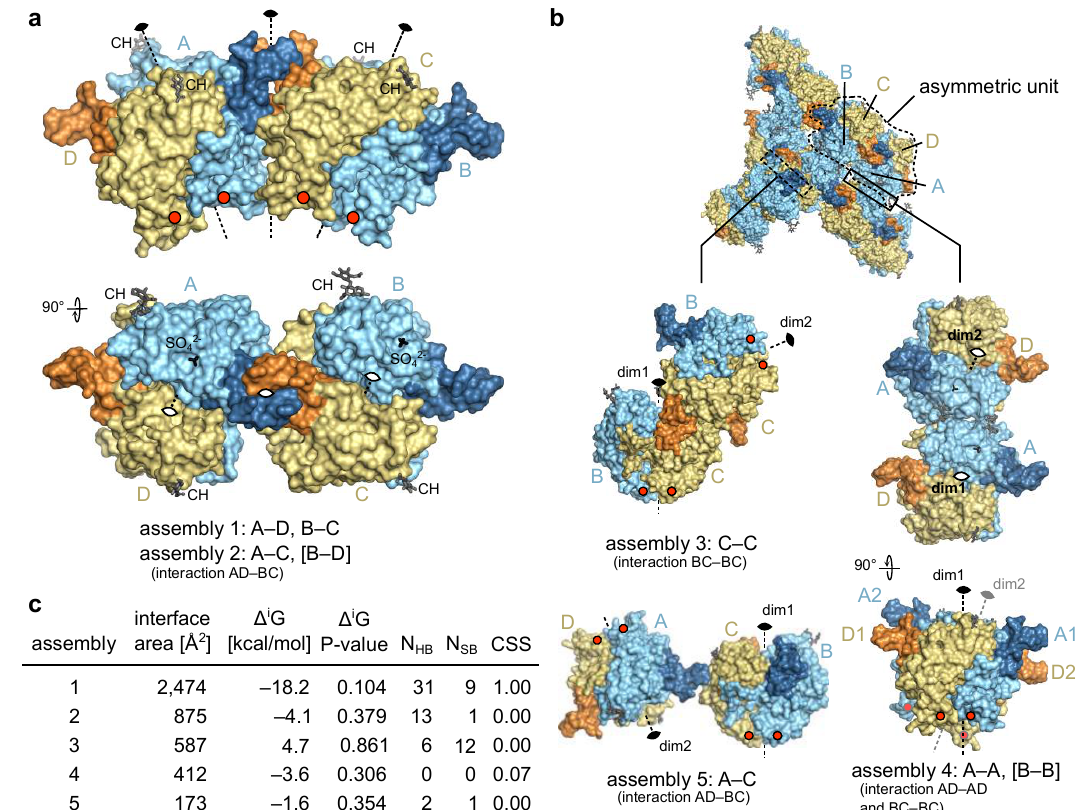
Figure 2. Molecular assemblies within the asymmetric unit and beyond. ( a ) In asymmetric unit, four polypeptide chains (chains A to D) corresponding to four copies of Trop2 ectodomain were found and are shown here as molecular surface. Chains A and B are shown in pale cyan and their N-terminal domains in dark blue, while chains C and D are shown in light yellow and their N-terminal domains in pale orange. Improper rotational (non-crystallographic) symmetry axes are shown as dashed lines and denoted with the standard 2-fold symmetry symbol. Sulfate ions (SO 42− , only in chains A and B) and N-linked carbohydrates (CH) are shown as black and dark grey sticks, respectively. Red dots indicate positions of C-termini. Interaction in square brackets is not shown, however it is implied by symmetry. ( b ) Alternative assemblies as devised from crystal contacts and with interface area larger than 150 Å 2 . Color-coding is the same as in ( a ). Dim1 and dim2 denote two-fold axis of each dimer. Interaction in square brackets is not shown, however it is implied by symmetry. ( c ) Table of assemblies and associated interface area, Δ i G and associated P-value, number of hydrogen bonds (N HB ) and salt bridges (N SB ) at the interface, and CSS as reported by PISA [38]. In case of two equivalent interfaces average values are reported, for example as in assembly 4.